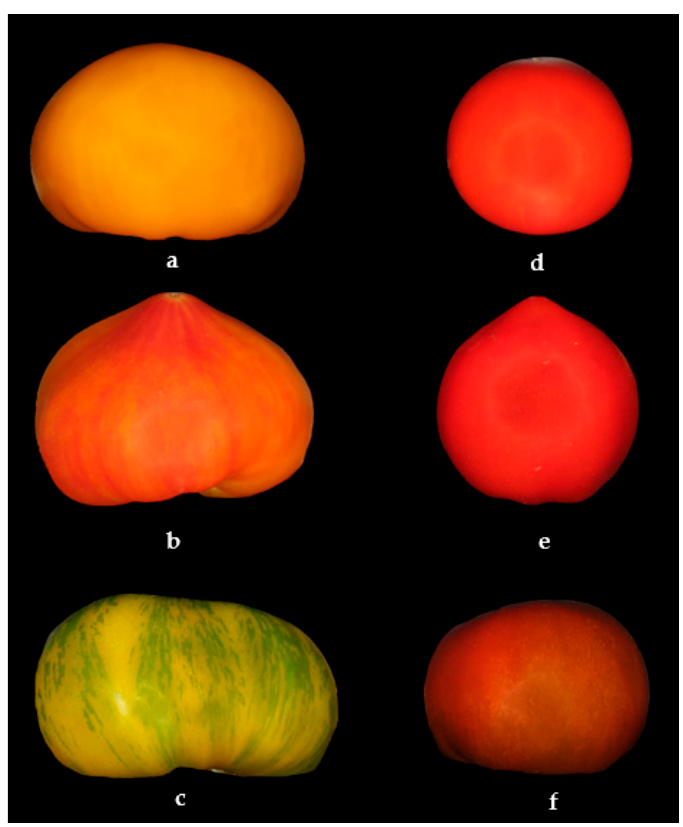
Figure 1. The sample color images of tomatoes ‘O ż arowski’ ( a ), ‘Marvel Striped’ ( b ), ‘Green Zebra’ ( c ), Sandoline F1 ( d ), Cupidissimo F1 ( e ), and Sacher F1 ( f ).